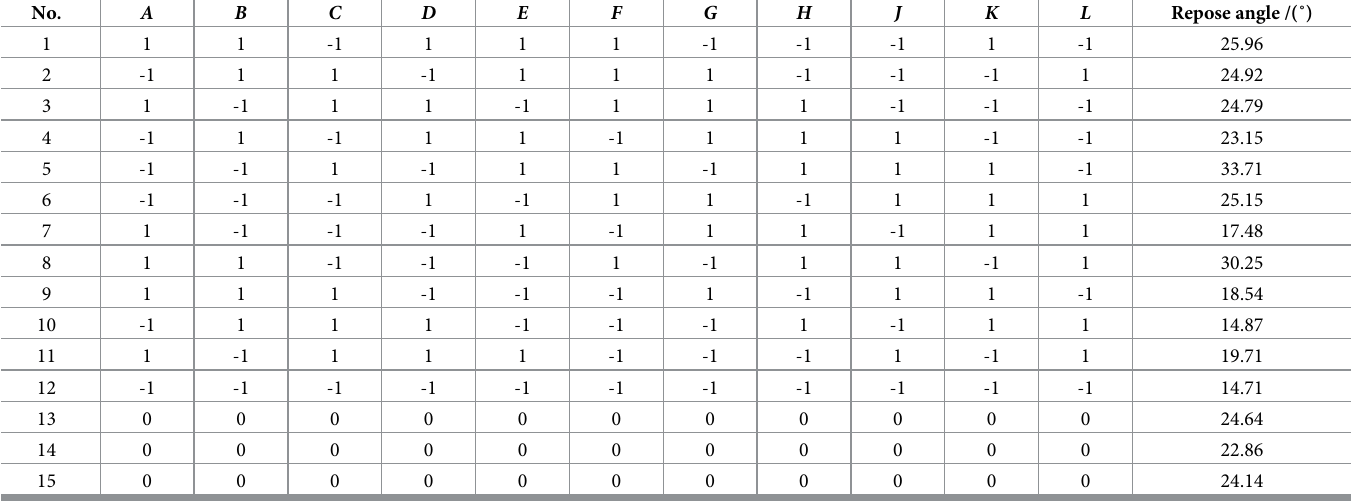
Table 3. Design and results of Plackett-Burman test